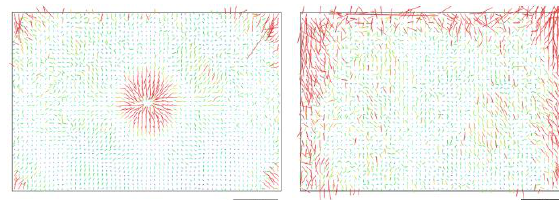
Figure 11. Systematic residual errors for the dome port (left) and flat port (right) resulted 1.4 um, more than three times worse. In general, the self calibration parameters of the flat port were an order of magnitude worse than those computed for the dome port. Such a worse precision is expected to be a source of systematic errors that accumulates along the photogrammetric strip and “vent” into the object space leading to a stronger global deformation of the 3D model for the flat port. Therefore, as shown in Nocerino et al. (2014), over the 70 meters linear perimeter of the underwater basin, the global deformations can reach some centimeters, even if the GSD was sub-millimetric.